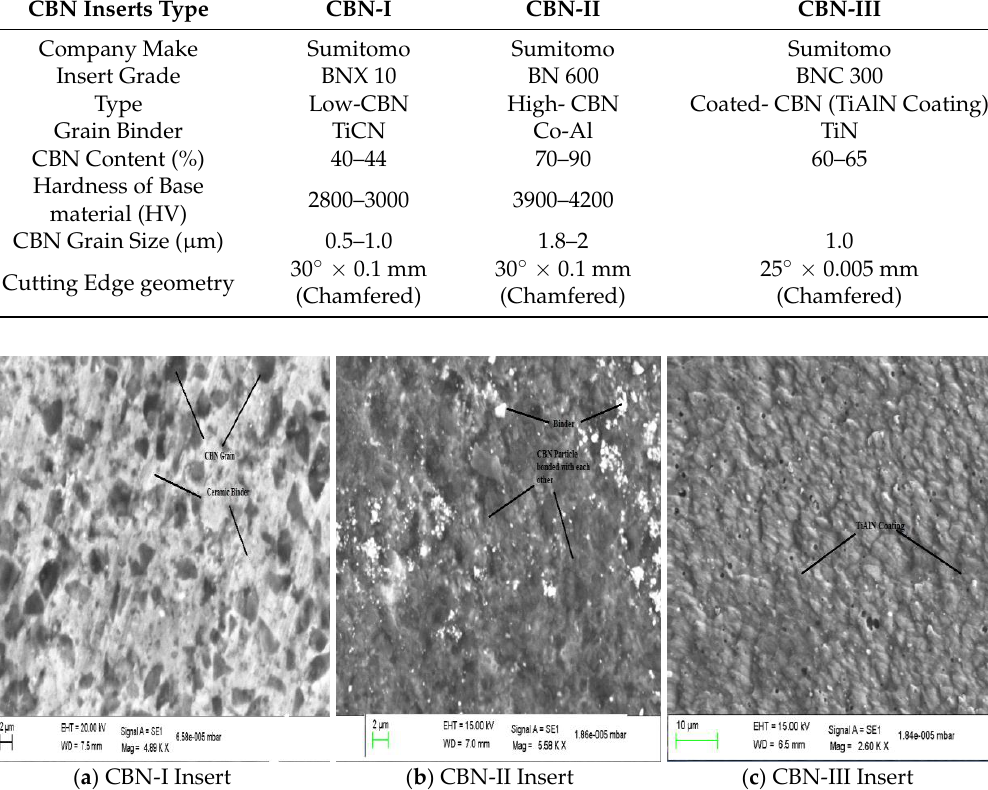
Figure 1. SEM images patterns of different CBN inserts.